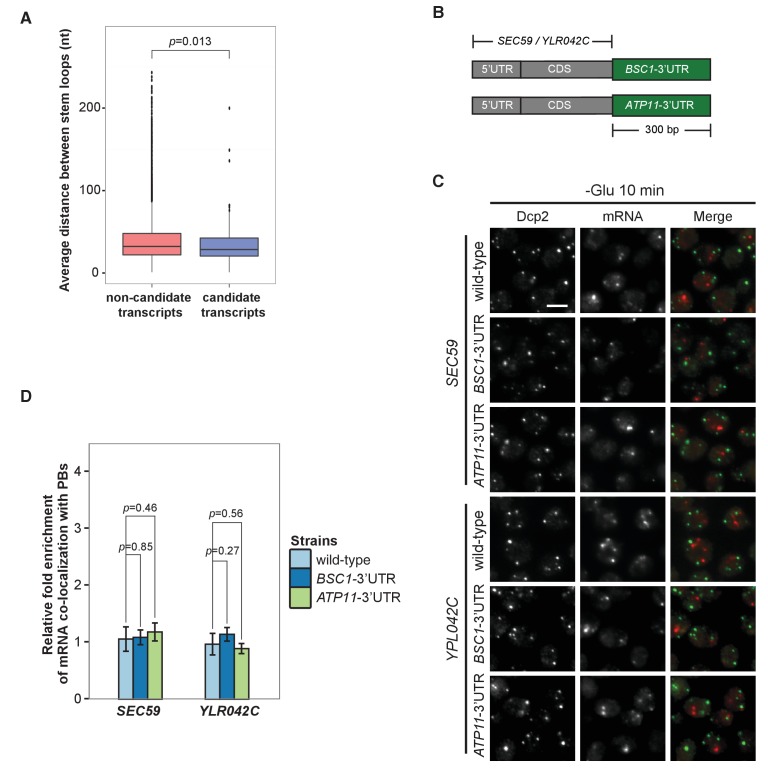
3’UTR is insufficient for mRNA localization to P-bodies.(A) Box plot of average distances between stem loops among the 3’UTRs of candidate transcripts versus non-candidate transcripts. A non-parametric, one-sided Wilcoxon rank-sum test was used to determine p values. (B) A schematic representation of 3’UTR transplantation chimeras. The endogenous 3’UTRs (300 bp downstream from stop codon) of SEC59 and YLR042C (300 bp downstream from stop codon) were replaced by the 3’UTRs of BSC1 and ATP11, respectively. (C) Fluorescence images of P-bodies and SEC59 and YLR042C mRNAs following glucose depletion. Scale bar, 5 μm. (D) Bar plot showing the relative fold enrichment of co-localization between SEC59, YLR042C and P-bodies in indicated chimeric strains 10 min after glucose withdrawal. Wild type is plotted as in Figure 2C. Error bars, mean ±SEM. A one-tailed, non-paired Student’s t-test was used to determine p values.10.7554/eLife.29815.031Figure 5—Figure Supplement 1—source data 1.Data used for plotting.